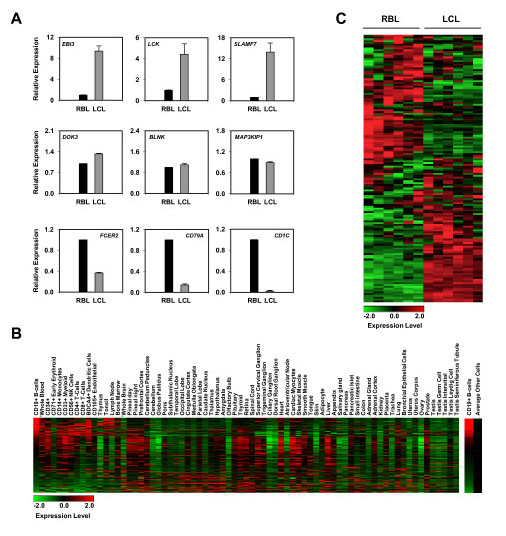
Expression analysis of genes undergoing hypomethylation during RBL to LCL conversion. (a) Expression analysis of selected genes in RBLs and matching LCLs. Error bars represent the standard deviation obtained from six independent measurements. (b) Heatmap showing the relative expression of the 256 genes hypomethylated in B cells with respect to other cell and tissue types. Expression data from Affymetrix mRNA expression analysis with 73 normal human tissues [36]. (c) Heatmap showing the relative expression of the 256 genes hypomethylated in B cells with respect to LCLs. Expression data obtained from GSE26212 [16].